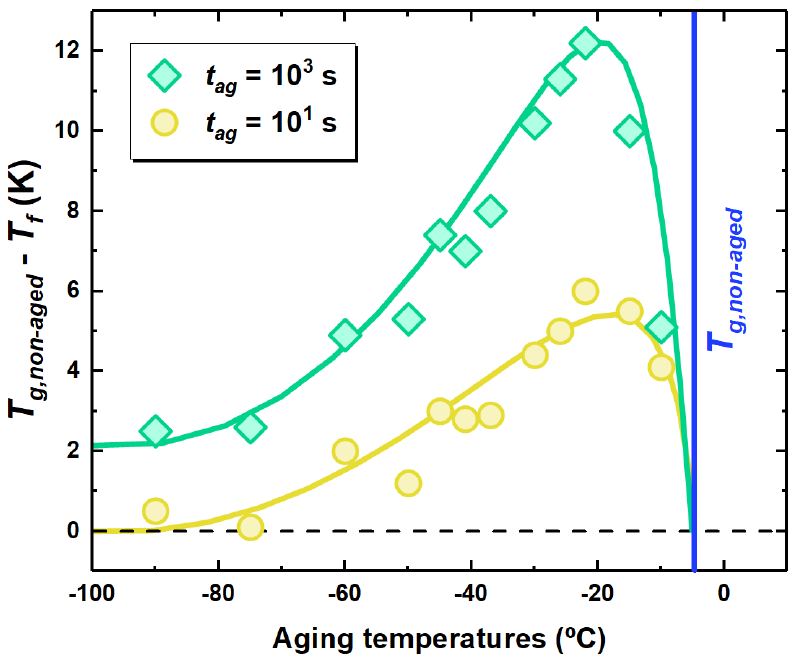
Figure 4. Evolution of T f , taken as the distance from T g , with the aging temperature for PCDM aged at the indicated aging